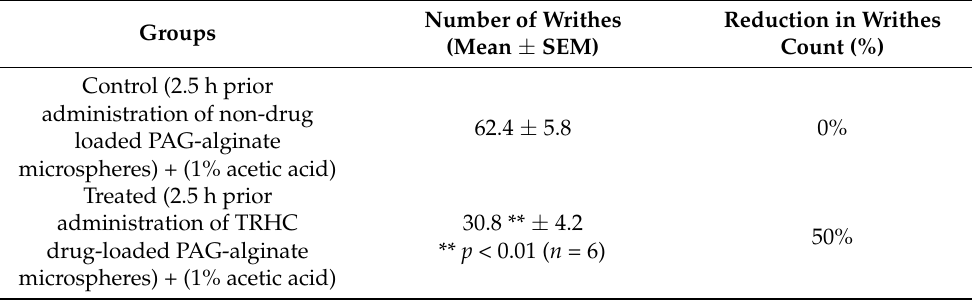
Table 9. Analgesic activity evaluation of TRHC-PAG-alginate microspheres. Groups